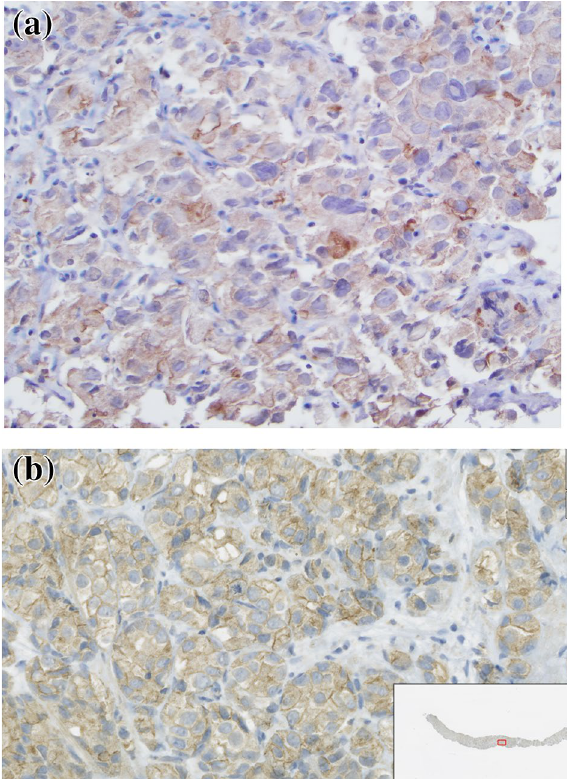
Figure 2. Immunohistochemistry anti-OATP1B3 antibody staining. ( a ) IHC slide of metastatic prostate cancer in lymph node. IHC using rabbit polyclonal anti-OATP1B3 antibody staining moderately positive (2+) with membranous and cytoplasmic distribution. ( b ) Slide of core biopsy of localized prostate cancer. IHC using rabbit polyclonal anti-OATP1B3 antibody staining moderately positive (2+) with membranous and cytoplasmic distribution.